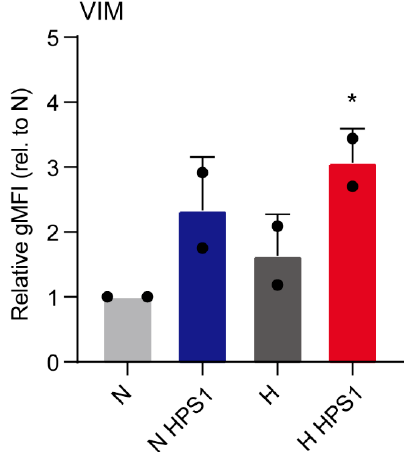
Figure A2. Hypoxic PS1 supernatant induces EMT only in hypoxic PDAC cells. Expression of VIM in PDAC cells was measured by flow cytometry and values were normalized to normoxic unconditioned medium group. Data show the average gMFI ± S.E.M. (* p < 0.05). Each dot refers to a cell line (PANC-1 and MIA